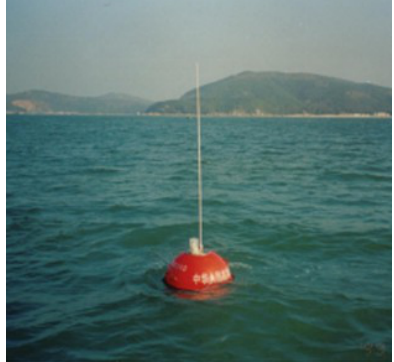
Figure 4. SBF series coastal telemetering wave